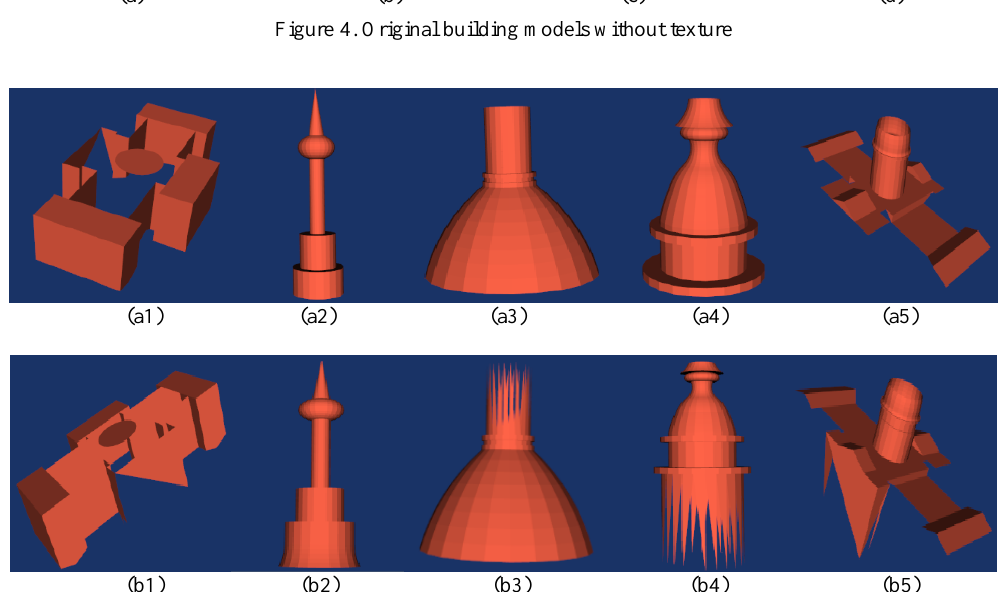
Figure 5. a1~a5 and b1~b5 respectively represent the ultimate segmentation using K-means++ and K-means clustering. And they correspond to the original model (a) in Figure